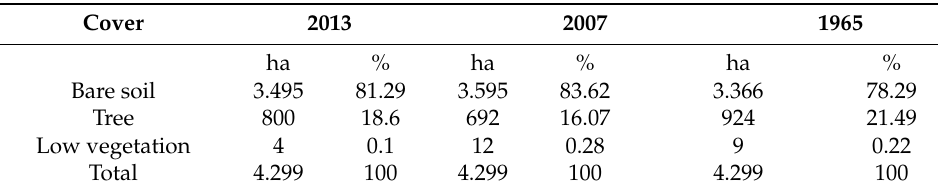
Table 7. Total area of coverage (CA) for the different